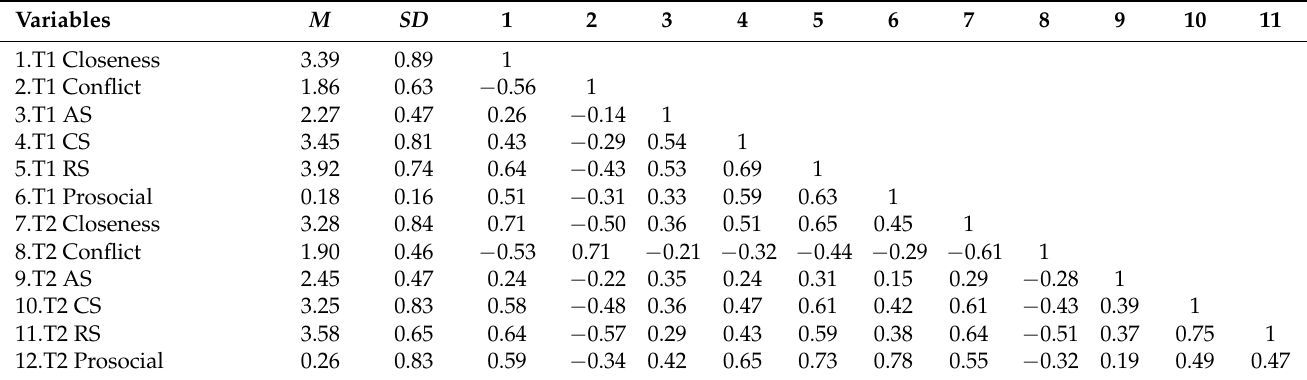
Table 1. Means, Standard Deviations, and Bivariate Correlations at Time 1 (T1) and Time 2